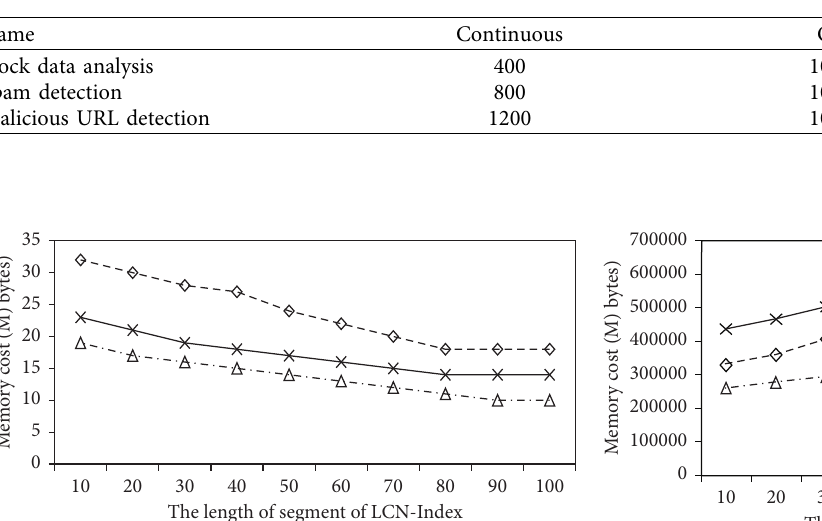
Table 1: Real world data streams.